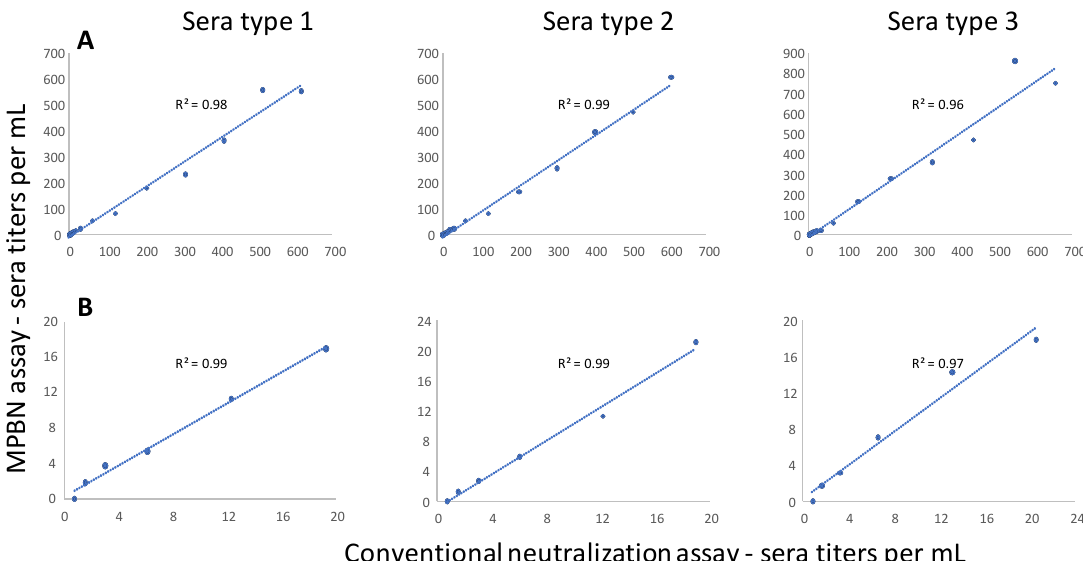
Figure 4. ( A ) : Evaluation of correlation between titration results of the conventional and MPBN assays. ( B ): Correlation of results of low-titer sera (from the data presented in A) analyzed with the conventional and MPBN assays.3.4. Robustness of the MPBN Assay.